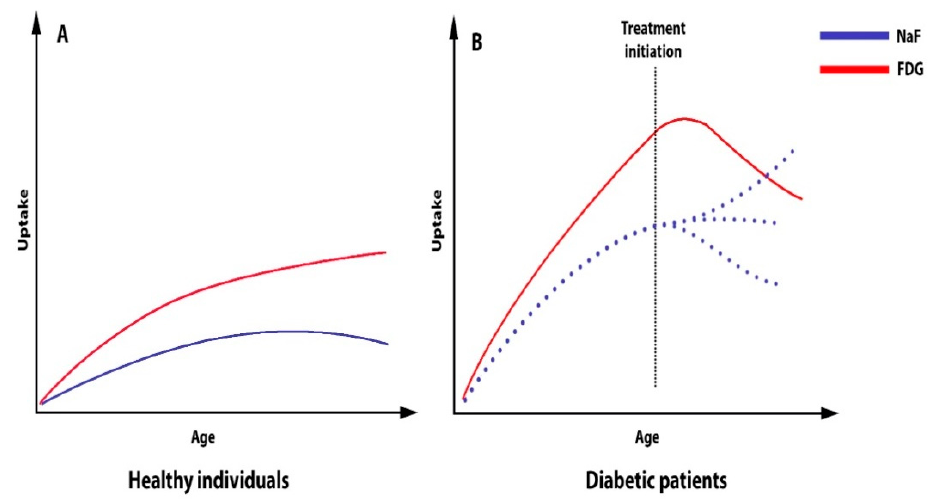
Figure 5. Schematic presentation of the arterial uptake of FDG and NaF in healthy individuals ( A ) and diabetic patients ( B ) as a function of age, as well as the effect of therapy (pioglitazone) on FDG uptake and the unknown effects (dotted lines) of any future attempts to influence NaF uptake.